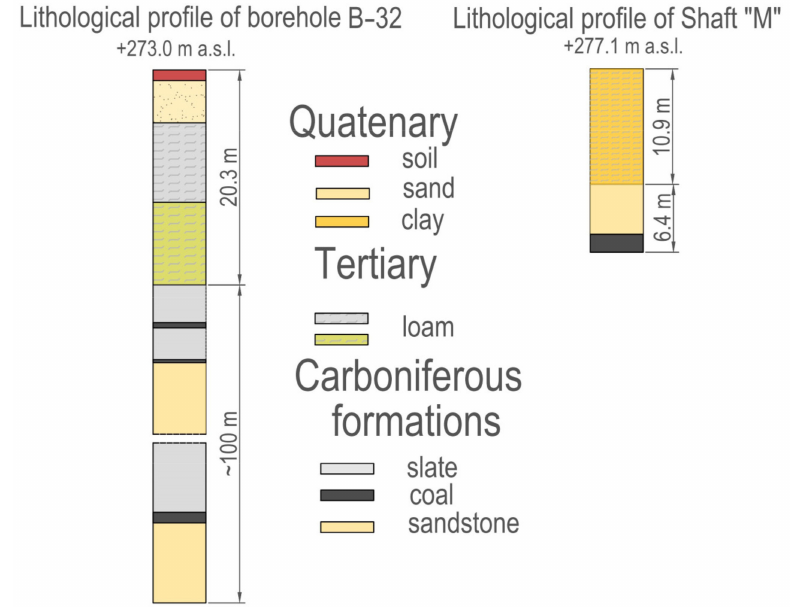
Figure 11. Lithological profile of the B–32 borehole and the “M”